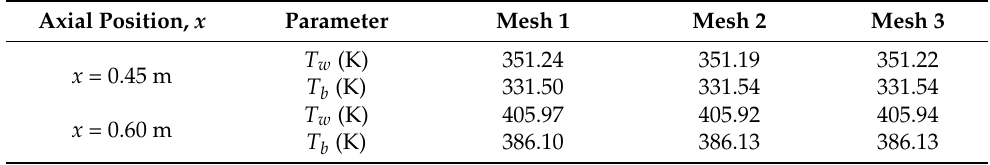
Table 2. The grid independence